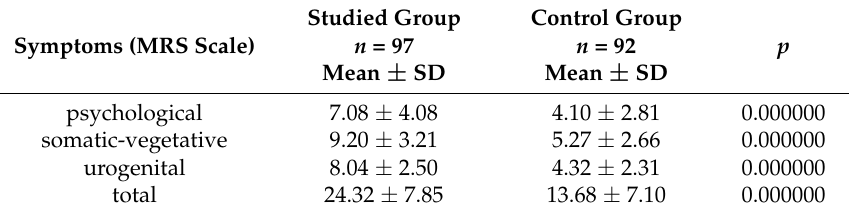
Table 2. The characteristics of menopause symptoms (MRS scale) in the studied and control groups.